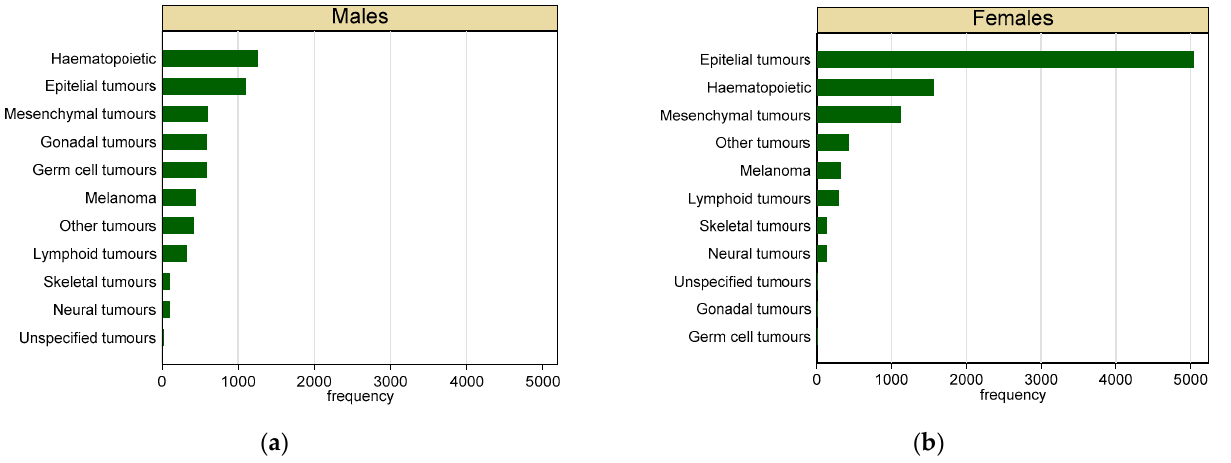
Figure 4. Frequency of malignant tumours in dogs by sex and tissue type. ( a ) Males; ( b ) females. As shown in Figure 5, not neutered males, when compared with neutered ones, had a significantly increased age-adjusted risk of malignant tumours in male sexual organs (PMR = 1.25, 95% CI 1.07–1.46), whereas being not neutered seemed to decrease the risk of eye, brain and meninges malignant tumours (PMR = 0.19, 95% CI 0.05–0.75). Not spayed females, when compared with spayed ones, had significantly increased age-adjusted risk of malignant mammary gland (PMR = 1.89, 95% CI 1.77–2.03) and other females sexual organs (PMR = 2.90, 95% CI 1.85–4.56), whereas being not spayed seemed to have a protective effect for malignant tumours of blood, haematopoietic system (PMR = 0.61, 95% CI 0.47–0.78), bones, joints and cartilage (PMR = 0.57, 95% CI 0.39–0.83), gastrointestinal tract (PMR = 0.75, 95% CI 0.58–0.98), oral cavity and pharynx (PMR = 0.49,95% CI 0.38–0.62), skin (PMR = 0.41, 95% CI 0.37–0.45) and soft tissues (PMR = 0.57, 95% CI 0.50–0.64).